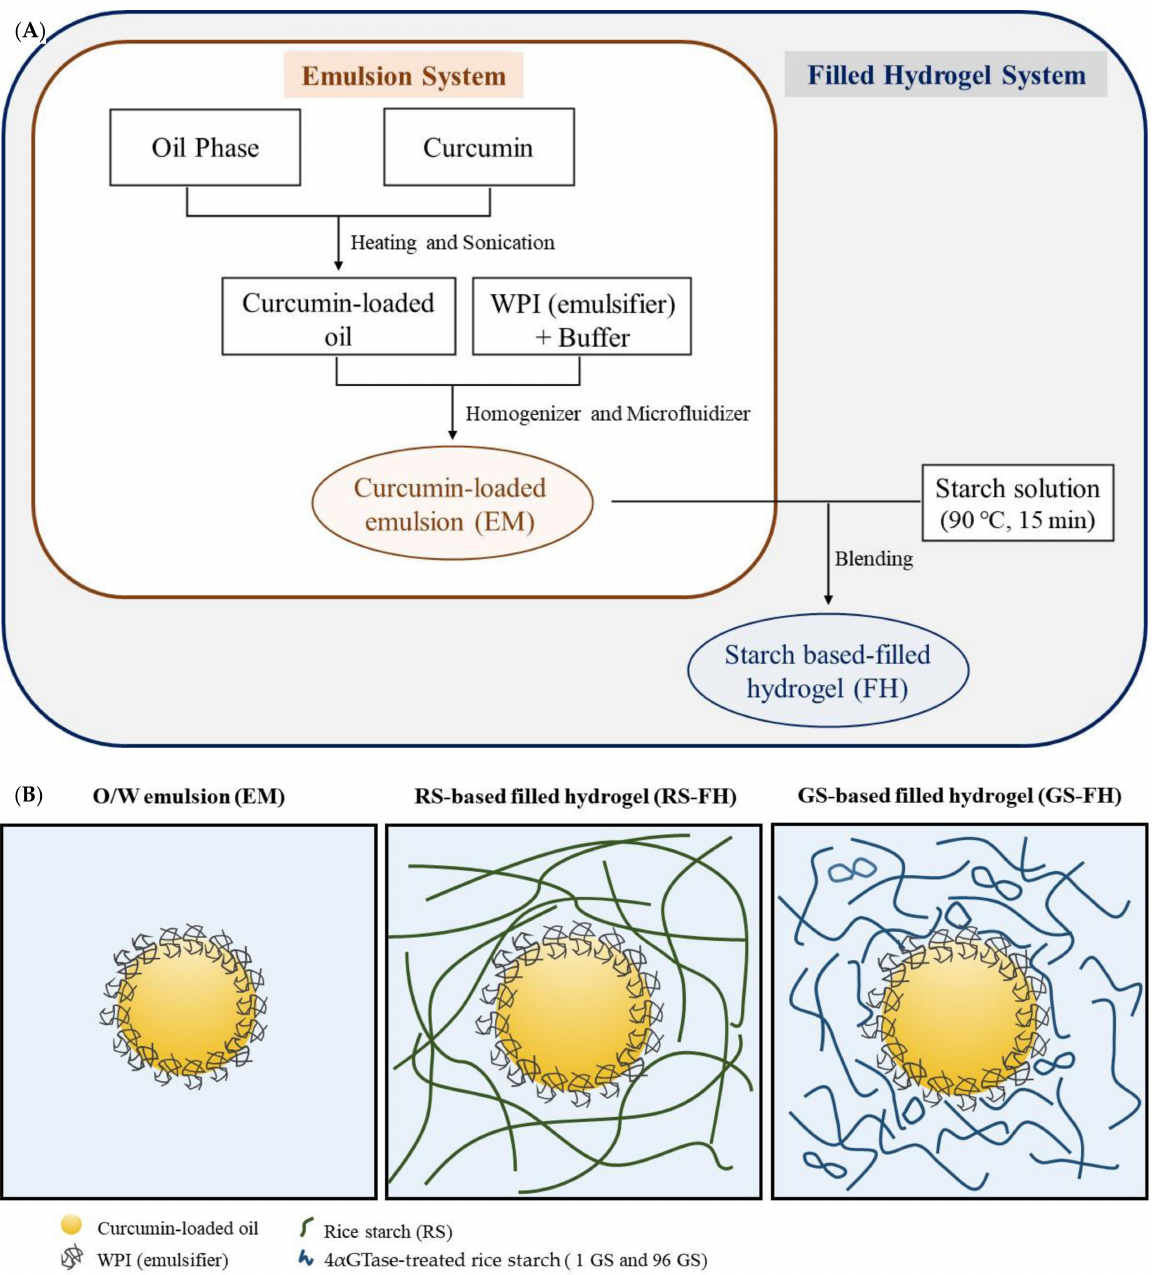
Figure 1. ( A ) Flow chart of manufacturing process for emulsion and filled hydrogel and ( B ) schematic representation of curcumin encapsulation systems. Left: oil in water (O/W) emulsion (EM), Middle: filled hydrogel prepared using rice starch (RS-FH), Right: filled hydrogel prepared using 4- α -glucanotransferase-treated rice starch